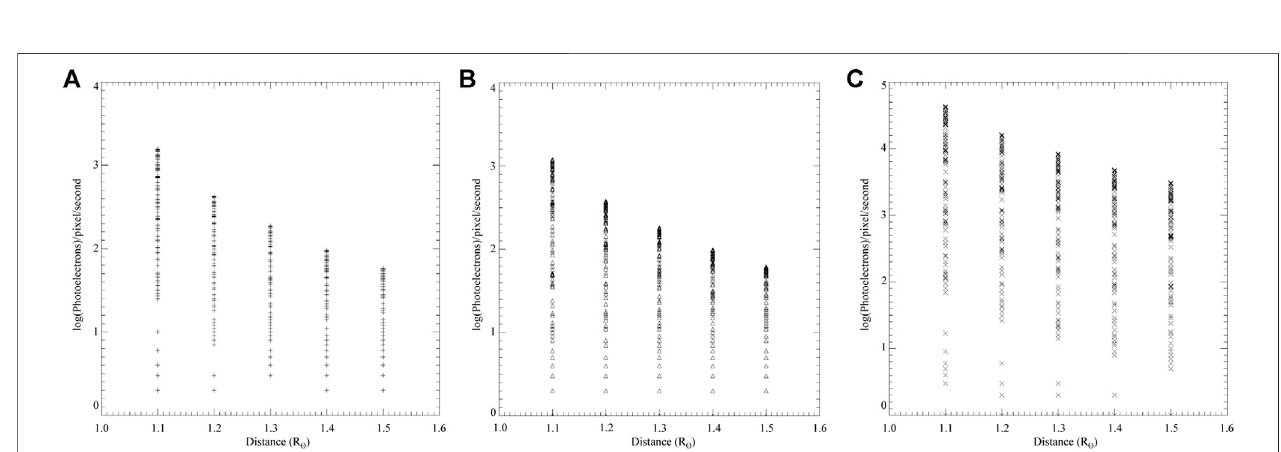
FIGURE 3 | Photoelectron variation using synthetic spectra for VELC at different heights for (A) 5,303 Å, (B) 7,892 Å, and (C) 10,747 Å for 50 μ m slit width with temperature distribution. It should be noted that the counts for the IR channel are about an order of magnitude greater than those for the other two channels, as the IR sensor pixels are larger than the visible sensor